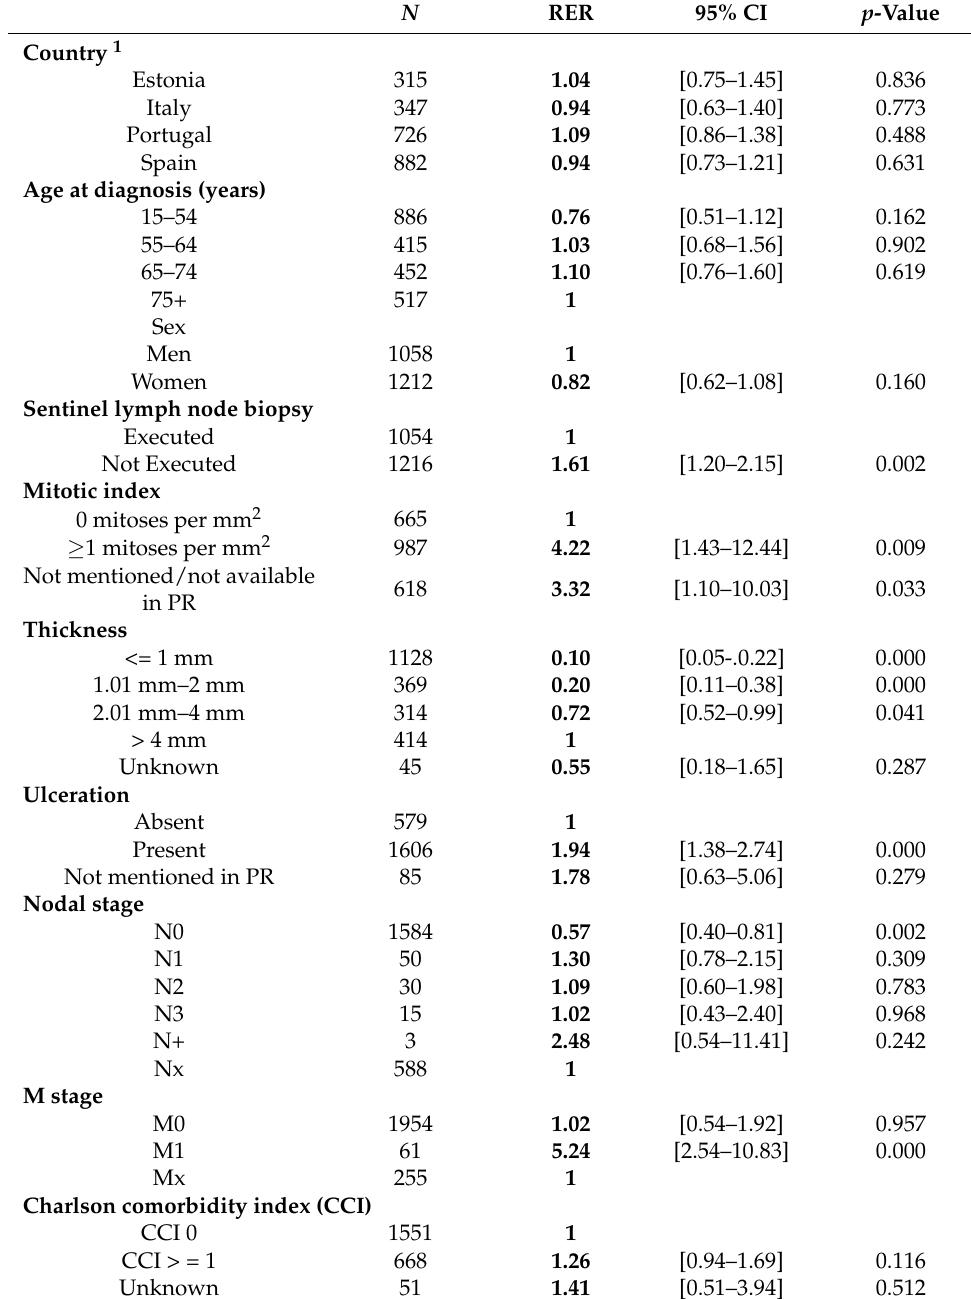
Table 4. Number of cases and adjusted 5-year Relative Excess rate of Risk of death (RER) with 95% Confidence Intervals (CI) for cutaneous melanoma patients diagnosed in 2009–2013 in four European